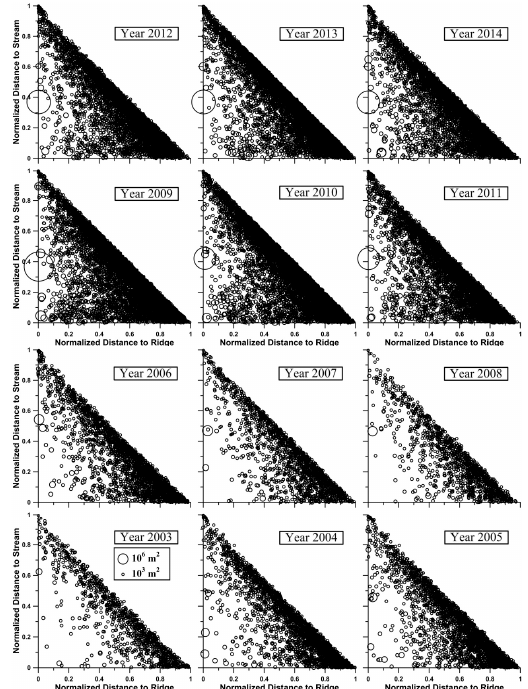
Figure 6. The landslide position analysis plots in the LRW from 2003 to 2014. Table 3. The statistical data of upslope, downslope, and midslope landslide cases in the three watersheds.